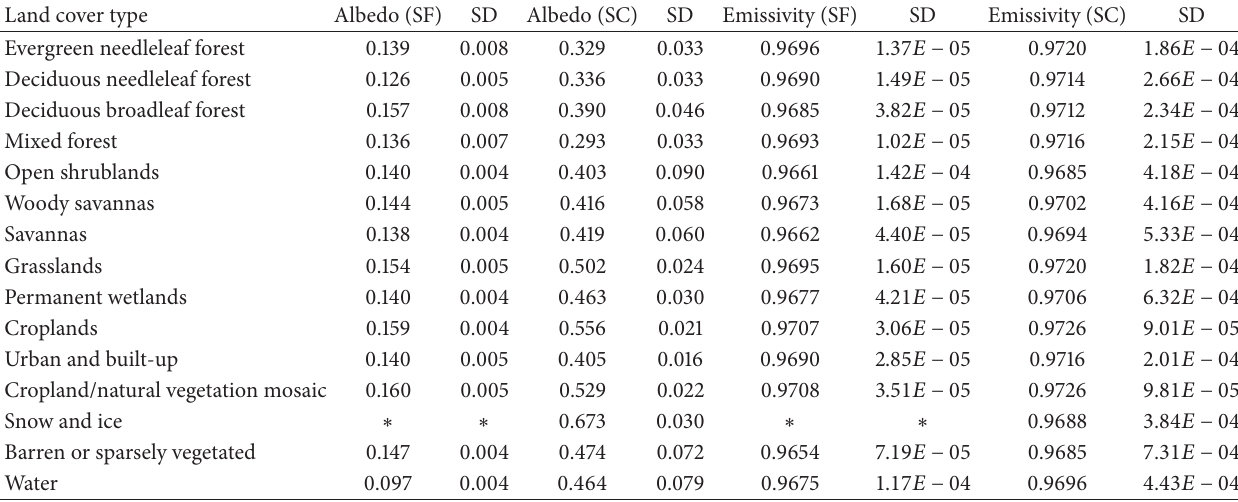
Table 1: Means and standard deviations (SD) of the snow-free (SF) and snow-covered (SC) white sky albedos and emissivities for each land cover class.